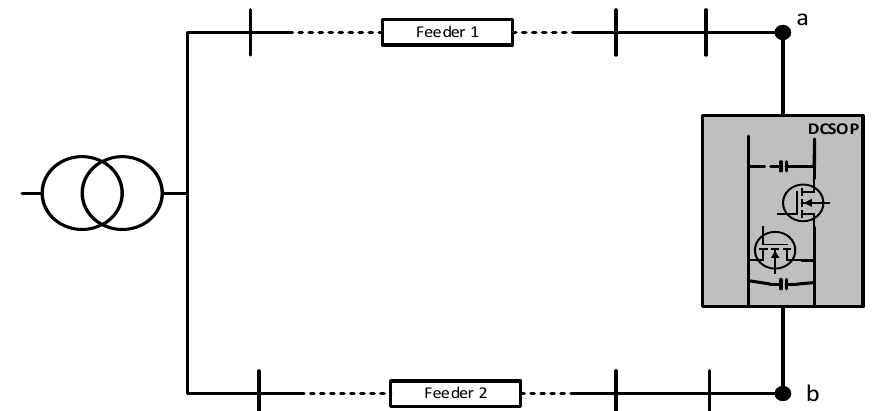
Figure 2. Control block diagram of the DCSOP.